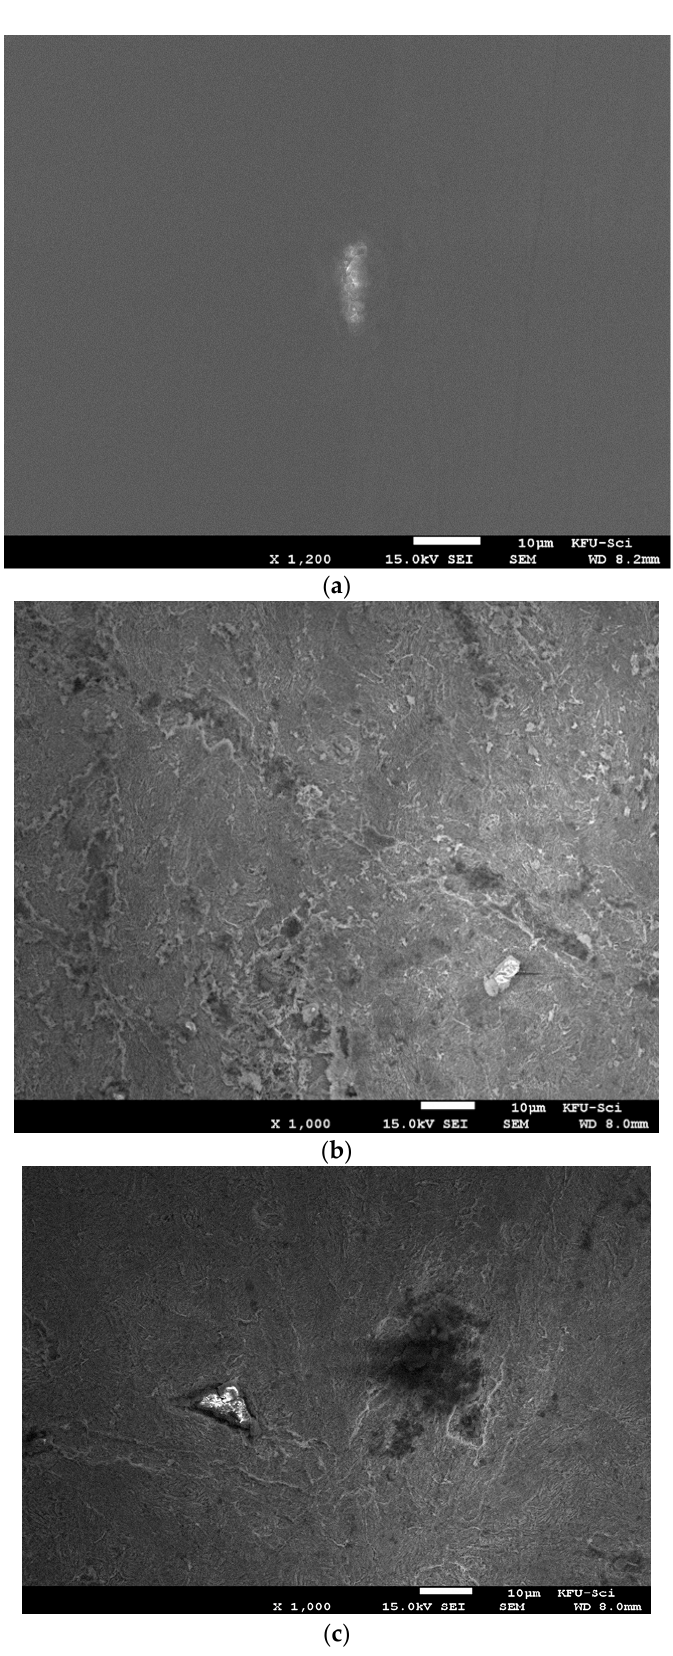
Figure 11. SEM micrographs for pristine C ‐ steel ( a ) and C ‐ steel immersed in 0.025 M H 2 SO 4 for 3 h: corroded C ‐ steel ( b ) and inhibited C ‐ steel by addition of Harmal extract (332 ppm) ( c ).